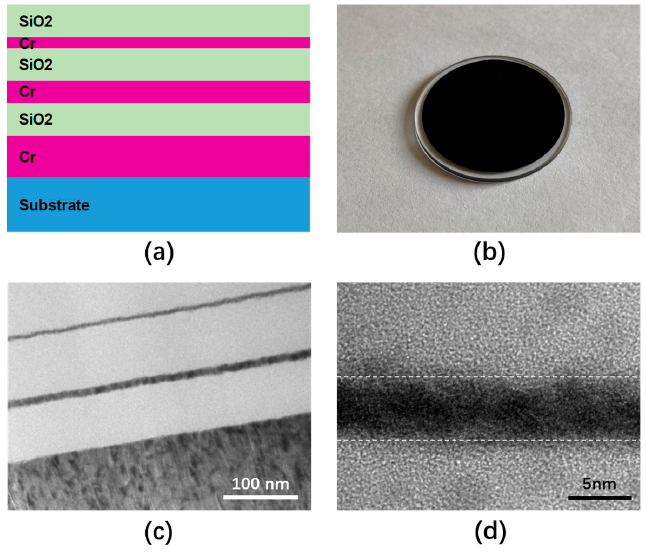
Figure 1. ( a ) The proposed absorber structure diagram; ( b ) a photograph of the fabricated absorber under 45° incidence; ( c ) the transmission electron microscopy (TEM) image of the absorber structures; ( d ) high-resolution TEM image.